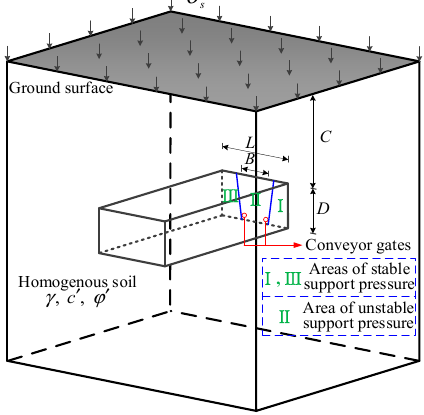
Figure 3. Profile of box tunneling.